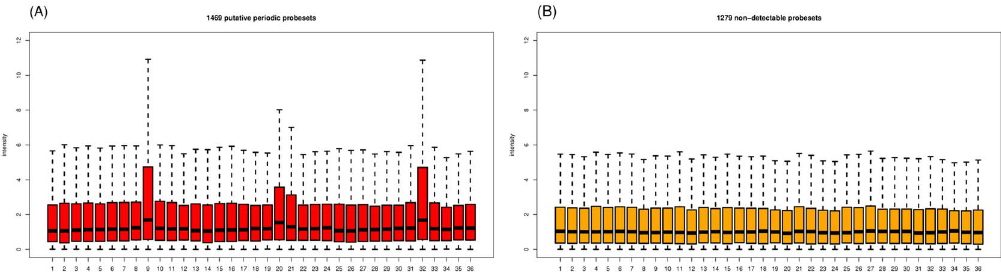
Figure 5. Boxplots of the expression profiles for (A) 1469 PP and (B) 1279 ND probesets.